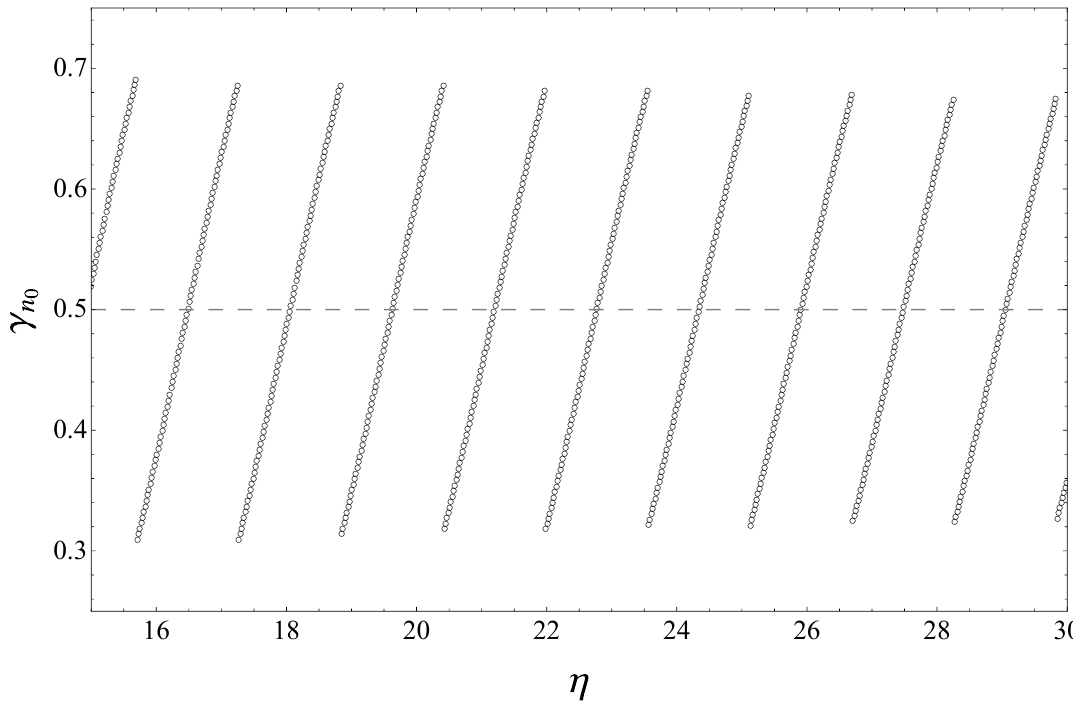
Figure 2. The eigenvalue γ n